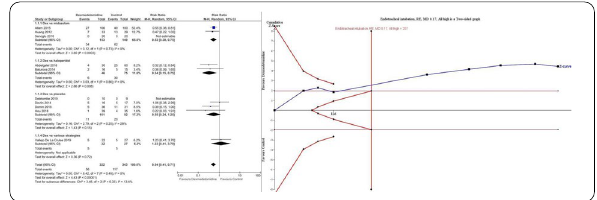
Figure 1. Forest plot analysis and Trial Sequential Analysis on tracheal intubation in ICU patients requiring NIV randomized to dexmedeto- midine or other sedation strategies with subgroup analysis. Analysis performed with random effect model and Mantel–Haenszel (M-H). CI: confidence interval, RRR: relative risk reduction. Conclusion. In critically ill patients receiving NIV, dexmedetomidine is associated with decreased risk of intubation, particularly if the alterna- tives are midazolam or haloperidol. A strategy of sedation with